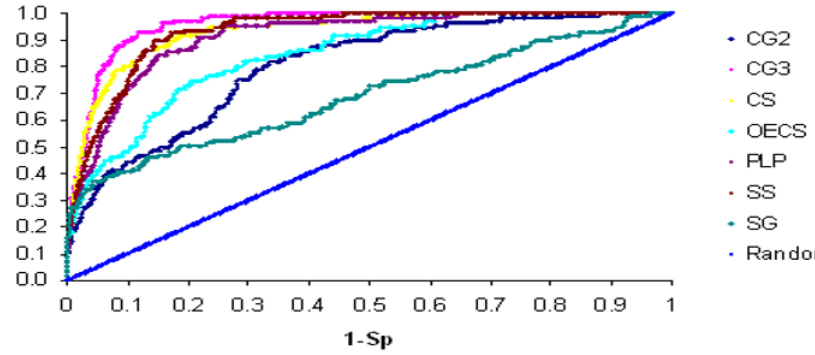
Figure 1. ROC plot obtained for the seven classical scoring functions included in